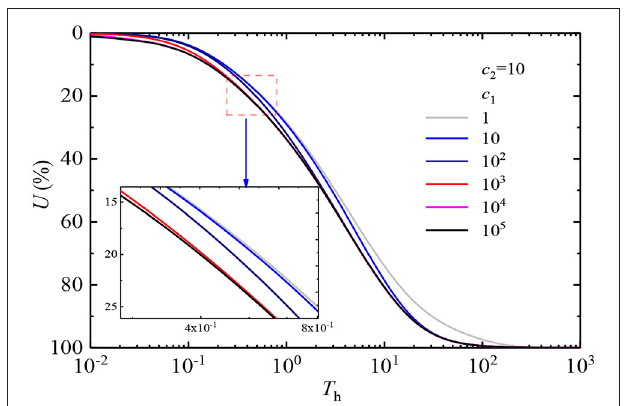
FIGURE 6 | Consolidation progress with different values of c 1 .